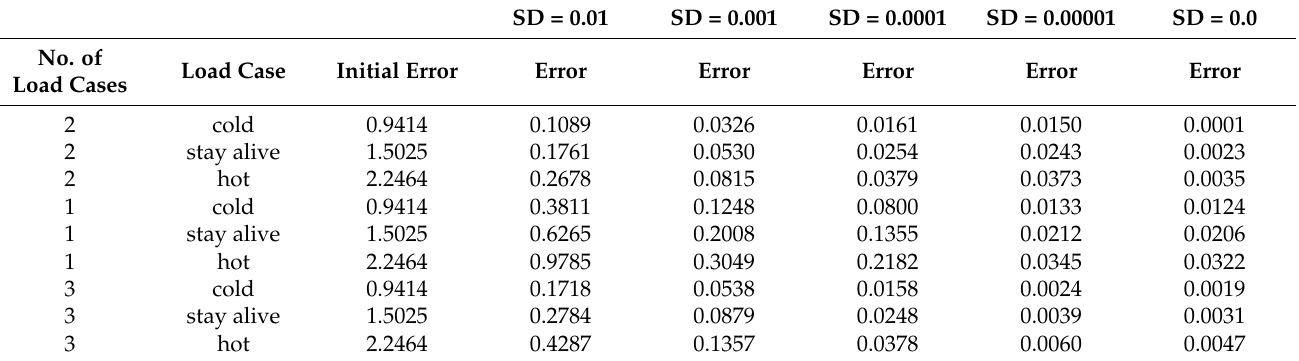
Table 6. Errors obtained for predicted temperatures for transient 4 nodes model, 1 unknown temperature. SD = 0.01 SD =